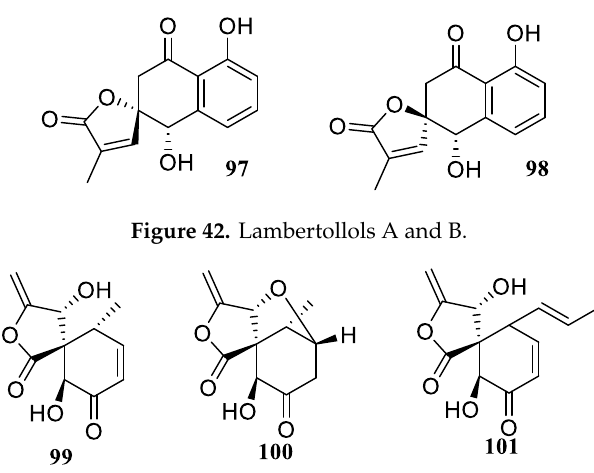
Figure 43. Spirocyclic lactones from traditional Chinese medicinal plant Rehmannia glutinosa .